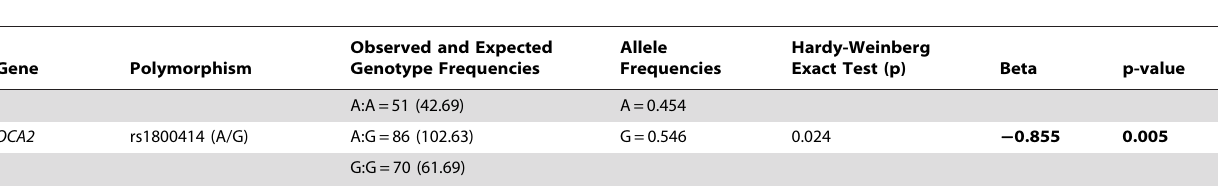
Table 4. Observed and expected genotype frequencies, allele frequencies, and Hardy-Weinberg exact test for rs1800414 in the Chinese Han